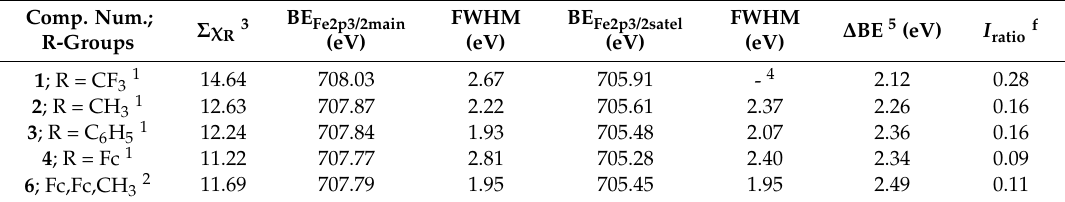
Table 3. Σχ R values, maximum binding energy (BE) of the main and satellite Fe 2p 3/2 envelope, peak separations between the satellite and main Fe 2p 3/2 peaks Δ BE, as well as I ratio values for 1 – 4 and 6 .